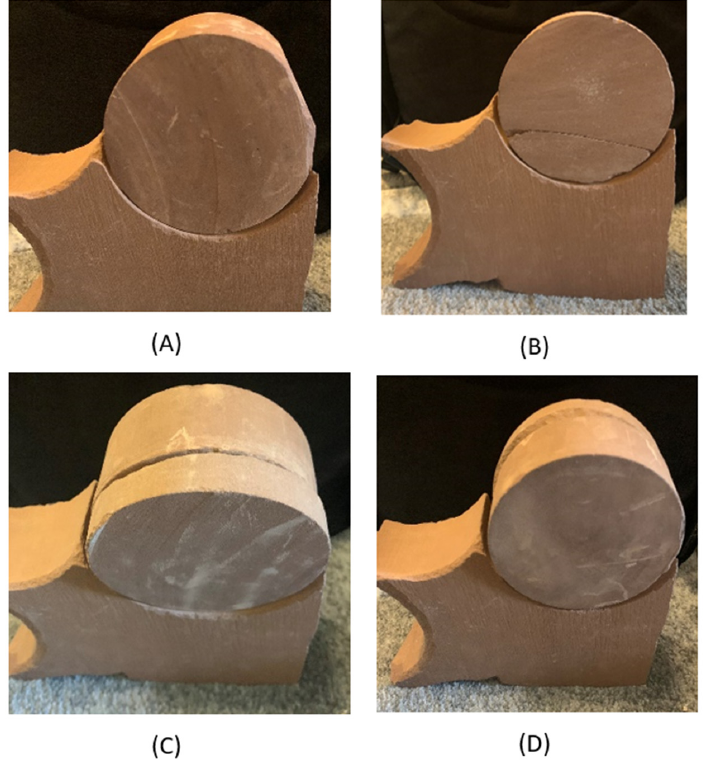
Figure 4. Stone specimens used in testing of BRUTUS 1: ( A ) unaltered stone; ( B ) stone with crack on top surface; ( C ) stone with shallow split; ( D ) stone with deep split.